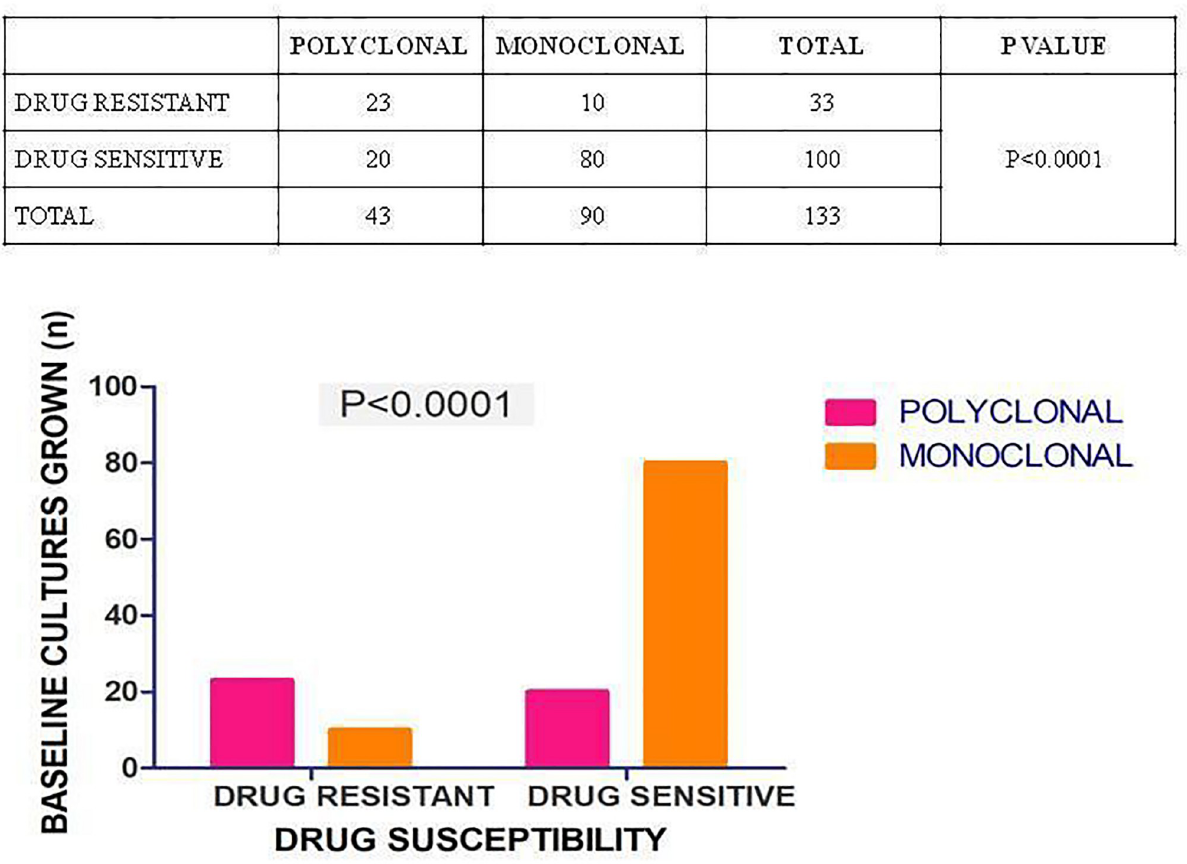
Fig 3. Association of polyclonal infections with drug resistant form of disease. Drug susceptibility test was performed on all baseline positive cultures (133). P value was calculated by Fisher’s exact test for determining the association of polyclonal disease with resistance. A p-value of < 0.0001 was regarded as